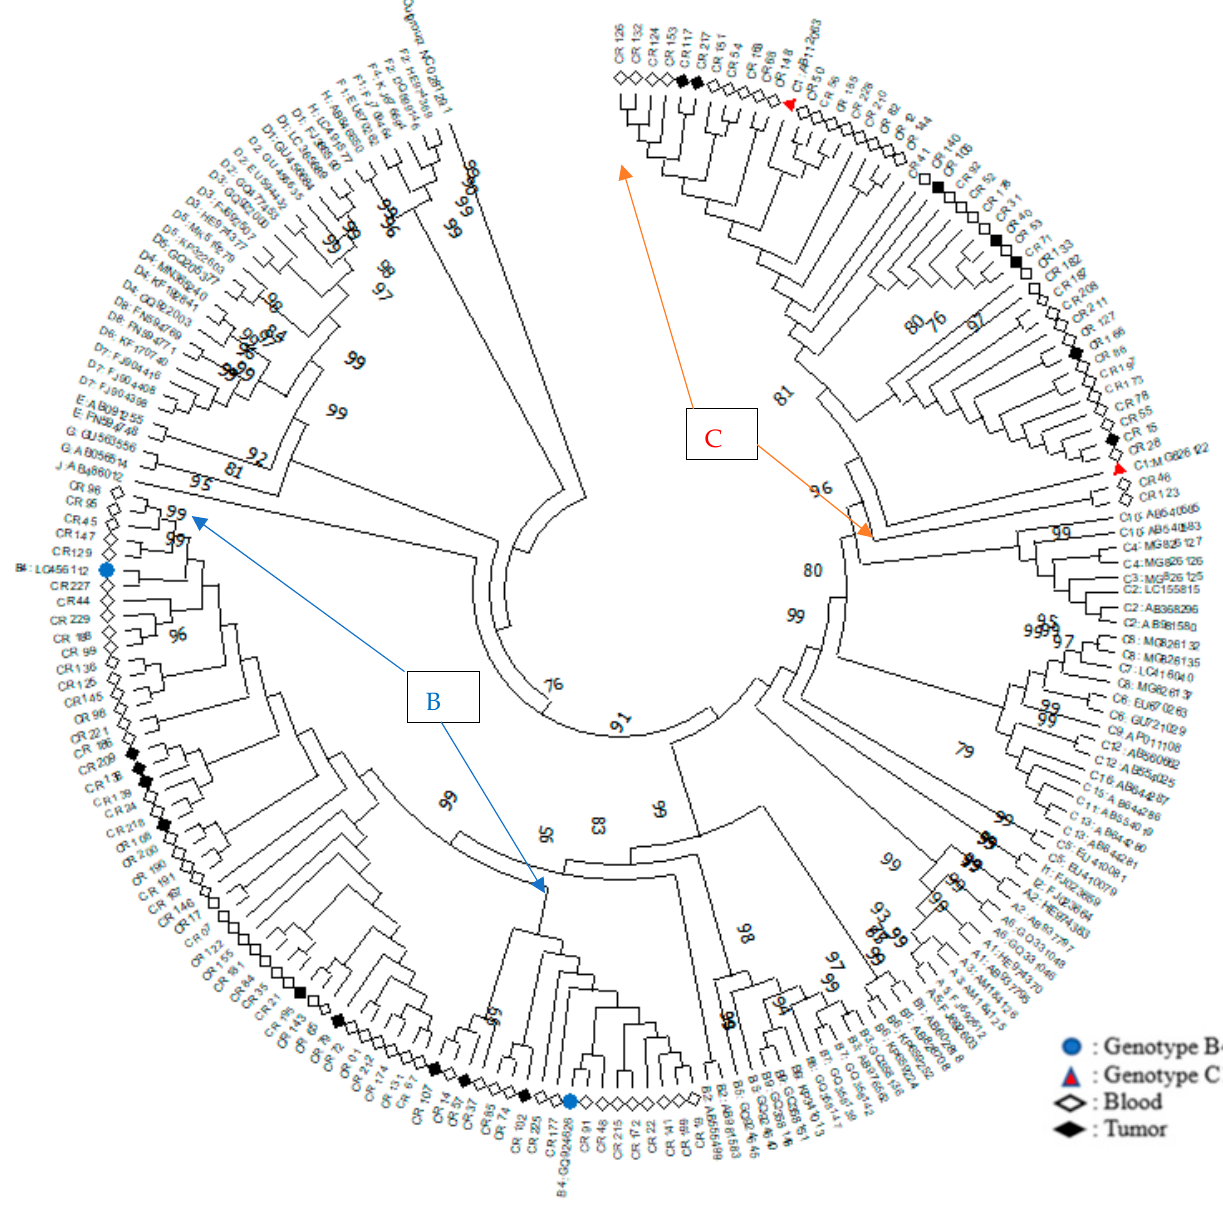
Figure 1. Phylogenetic tree of 107 HBV samples with reference sequences of each genotype (A–J) and their corresponding